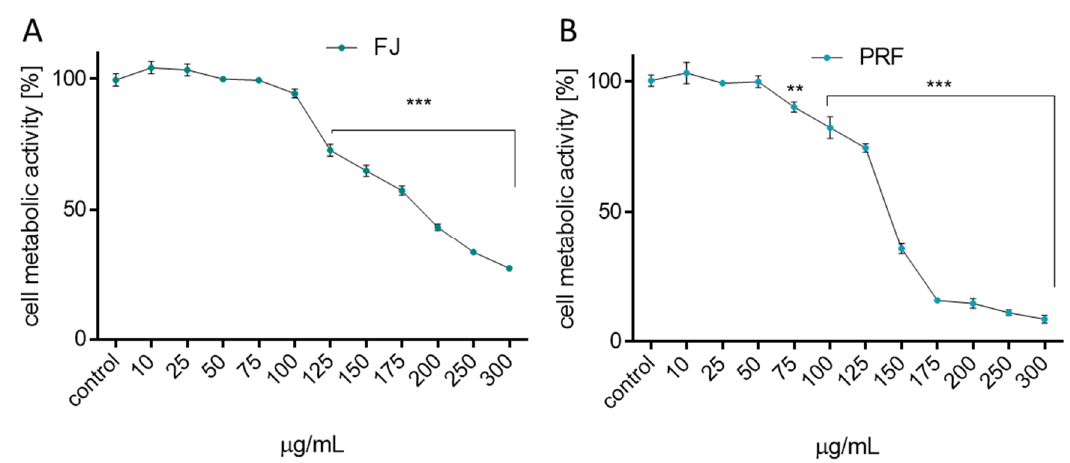
Figure 1. The influence of V. opulus extracts on MIN6 cell metabolic activity determined by PrestoBlue assay after 24 h exposure of juice (FJ) ( A ) and PRF ( B ). Control cells were not exposed to any compound but the vehicle; values are means ± standard deviations from at least three independent experiments, n ≥ 12; statistical significance was calculated versus control cells (untreated), ** p ≤ 0.01, *** p ≤ 0.001.